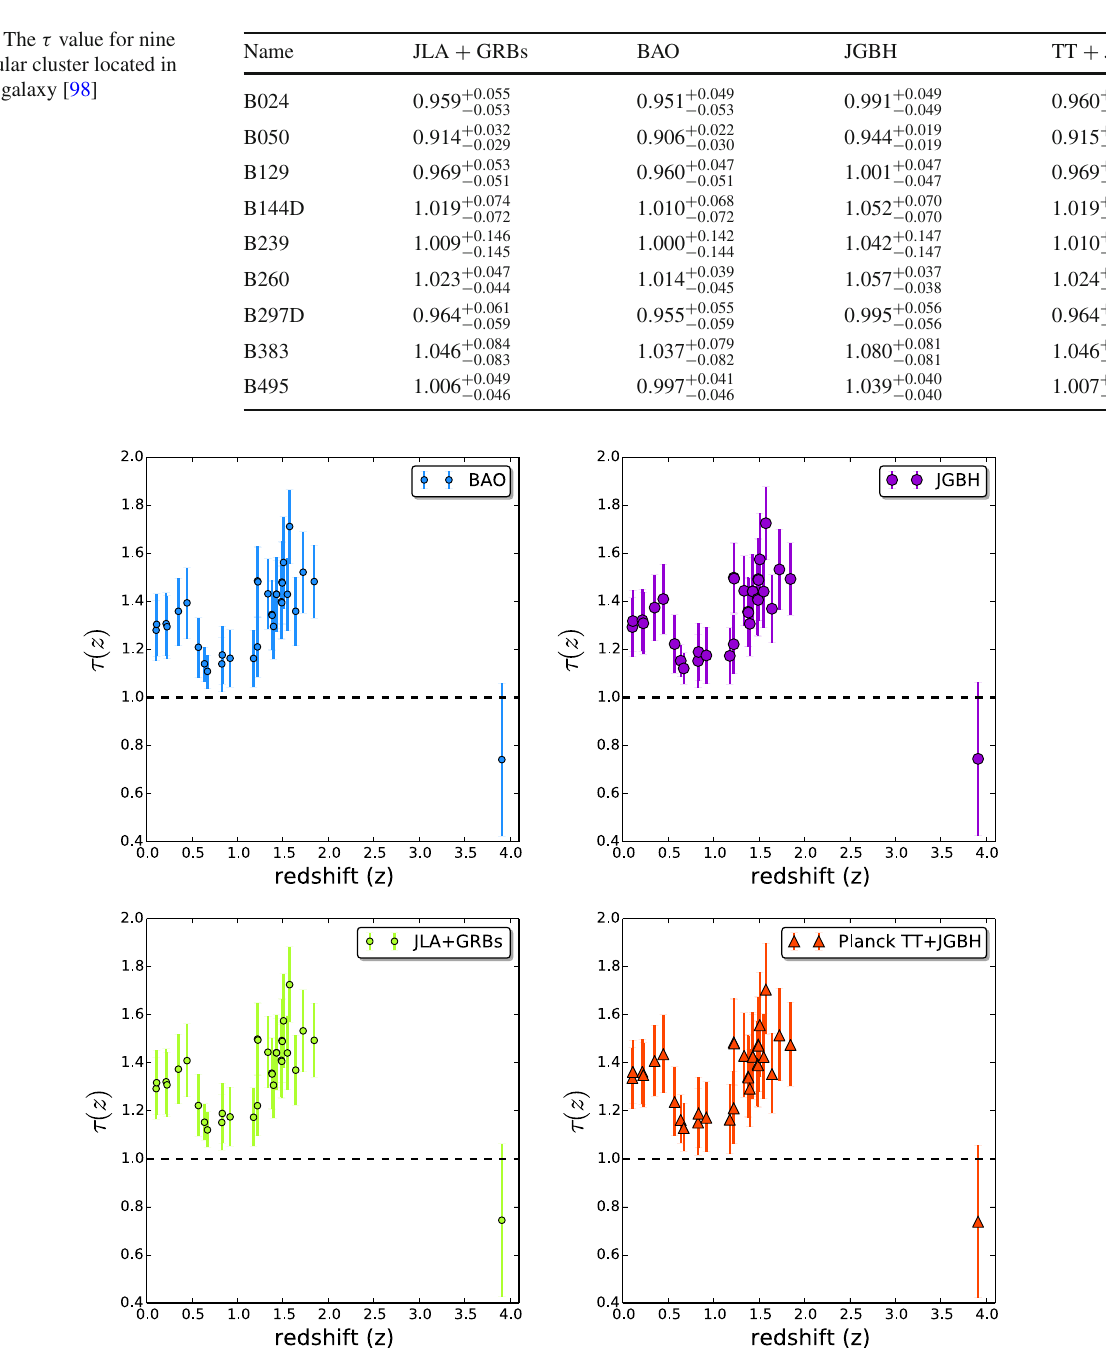
Fig. 19 τ as a function of the redshift for 32 old objects. Data have been given from